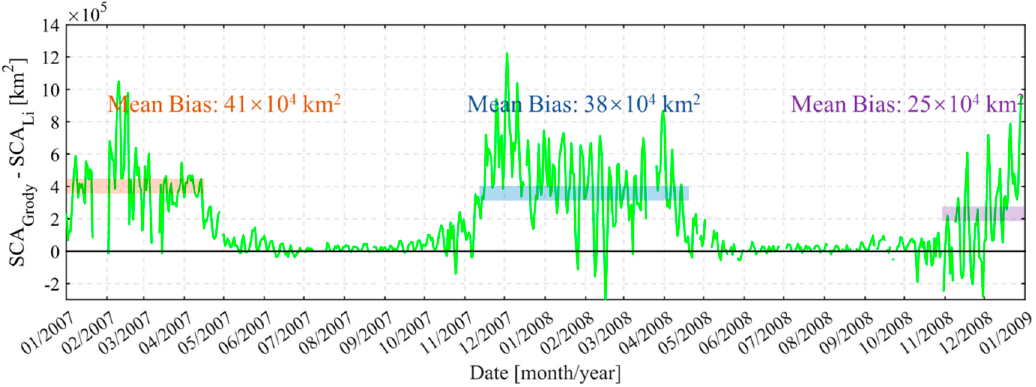
Figure 6. Time series of snow cover area difference between Grody and Li methods.